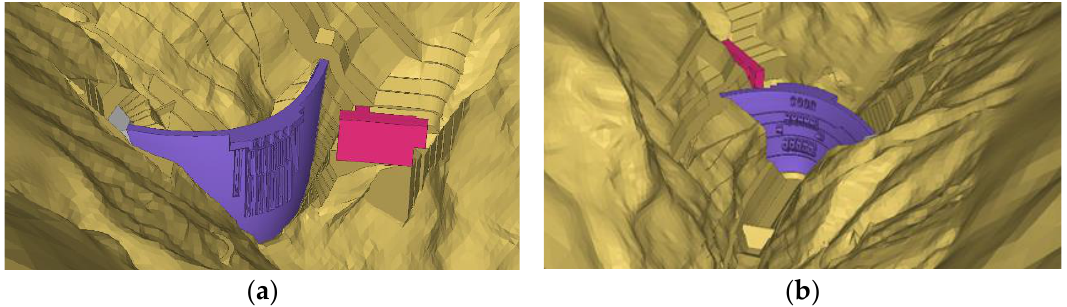
Figure 7. Finite element model of the dam body and mountains near the Jinping I super-high arch dam. ( a ) Dam upstream surface. ( b ) Dam downstream surface.